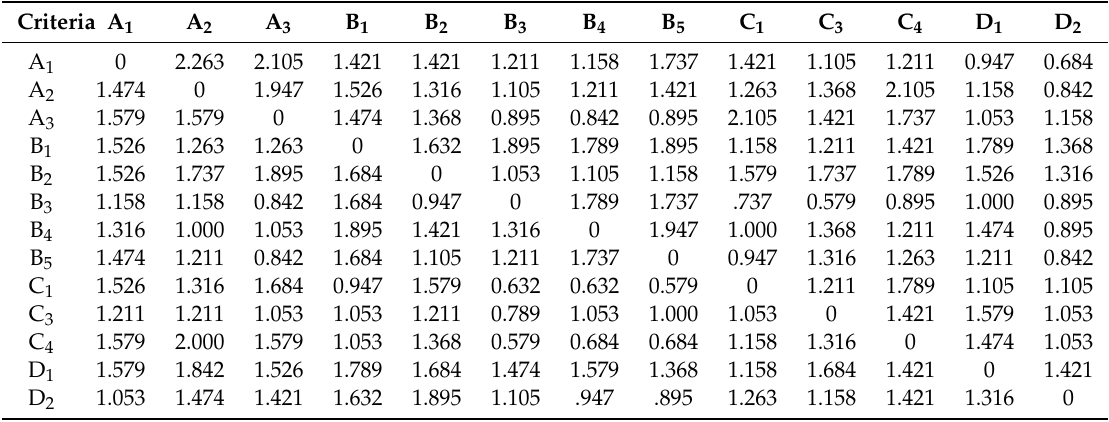
Table 5. Average matrix A D of criteria.